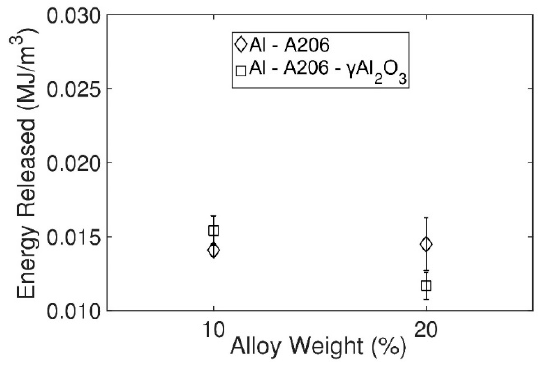
Figure 17. Energy released during the PLC phenomenon at a 0.500 mm/min strain rate.